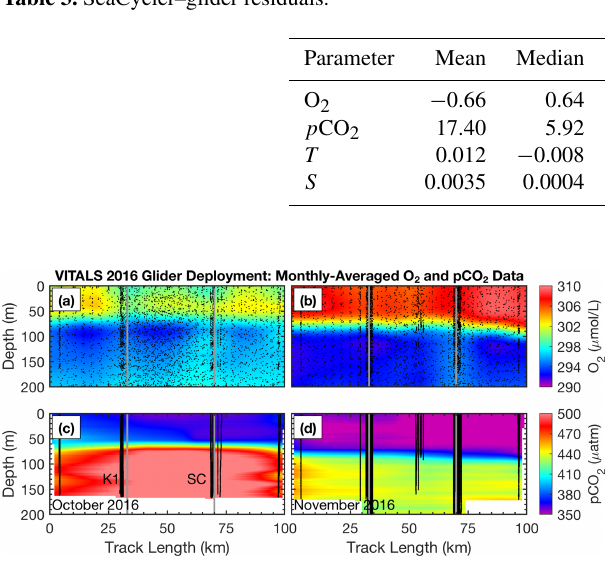
Figure 6. Glider monthly averaged spatial section of (a) O 2 in Oc- tober and (b) November as well as for p CO 2 in panels (c) and (d) , respectively (along-track positions are shown in the blue inset map in Fig. 1). Along-track locations of the K1 mooring and SeaCycler are indicated by vertical lines as are individual glider profiles used for plotting. For glider O 2 data only every 25th data point is shown for